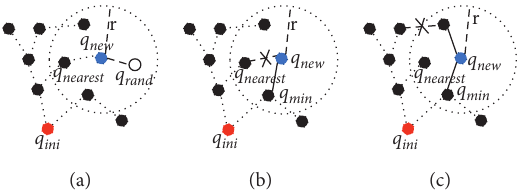
Figure 2: The path optimization process. (a) Node expansion. (b) Parent node reconnection. (c) Random tree